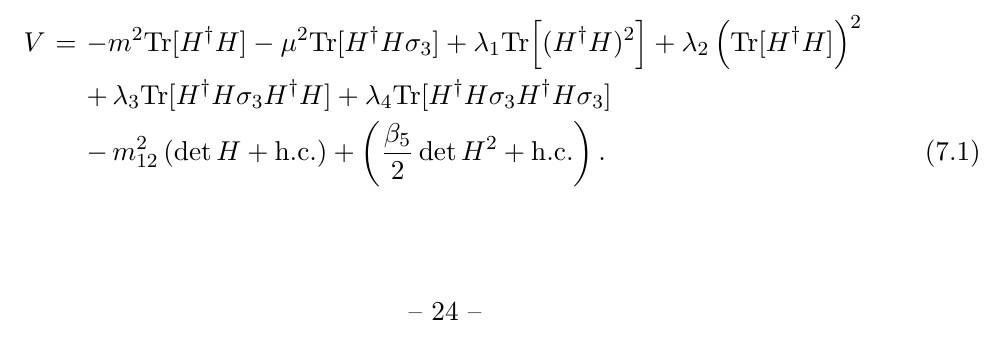
0 ; 8 for the lower two panels (b). The other parameters are set as 5 (cid:0) (cid:1)